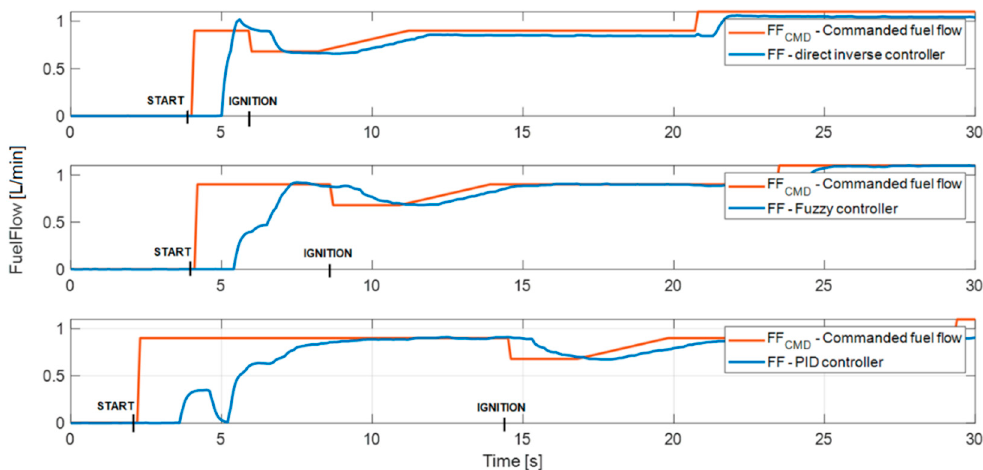
Figure 18. Performance of the controllers during start ‐ up of the engine.